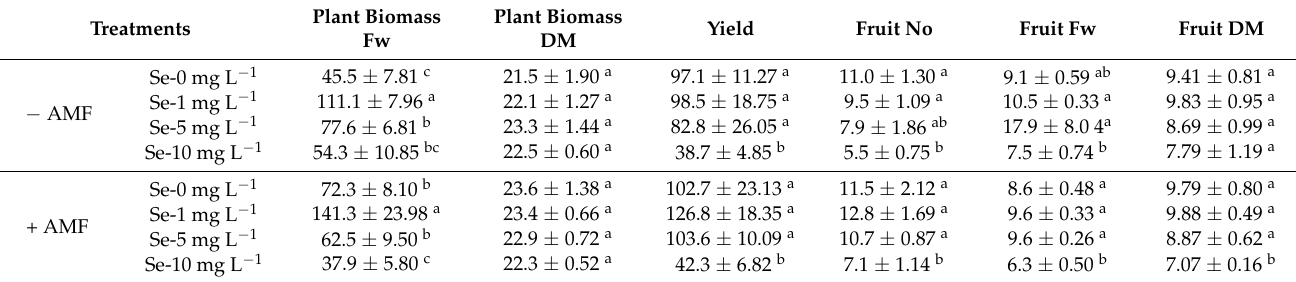
Table 2. Effects of arbuscular mycorrhizal fungi (AMF) inoculation and selenium (Se) levels (0, 1, 5 and 10 mg L − 1 ) in the nutrient solution on plant biomass (g plant − 1 ), dry matter content (%), yield (g plant − 1 ), fruit number and fruit weight (g plant − 1 ) in hydroponically grown strawberries in